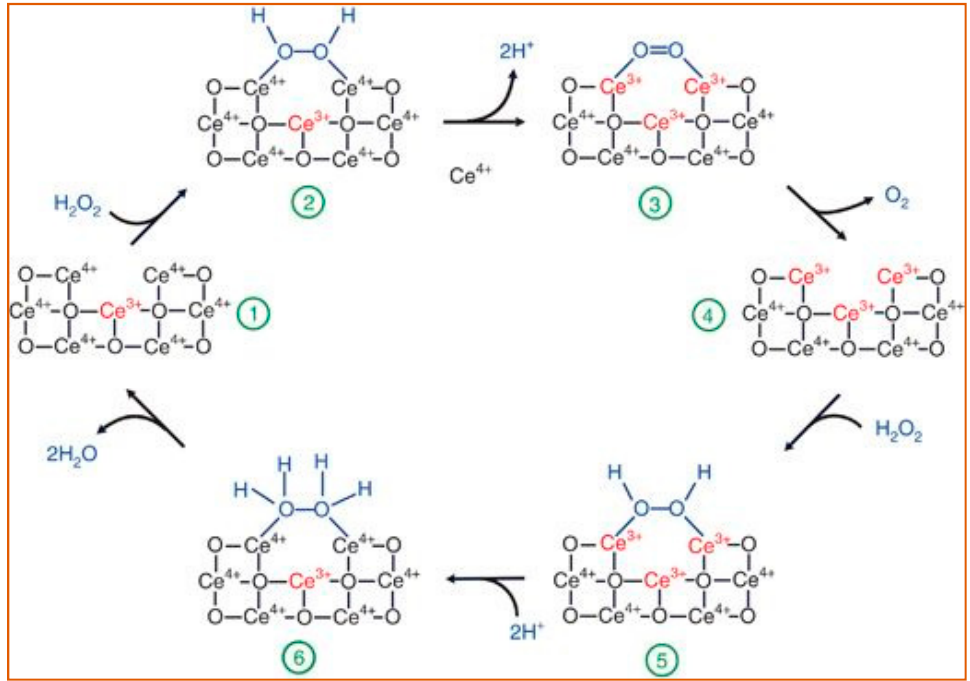
Figure 7. A review of the reaction mechanism of cerium oxide nanoparticles (CeO NP) catalyzes the H 2 O 2 with its superoxide dismutase-like activity. During the entire process, the amount of bound Ce 3+ /Ce 4+ (red font) changes with the structure of the oxygen-containing groups (blue font), causing the catalyzation of H 2 O 2 [97]. The reactants and products are indicated at each stage of the reaction, 1–6. Reprinted with permission from ref. [97]. Copyright 2011 Nanoscale.